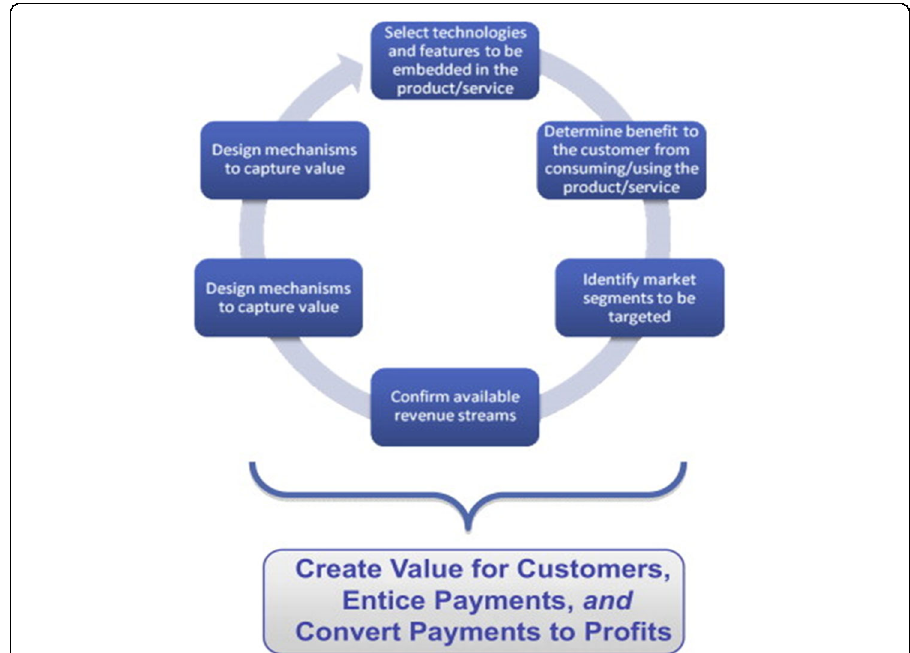
Fig. 3 Business cycle framework. Source (Tian et al., 2011)